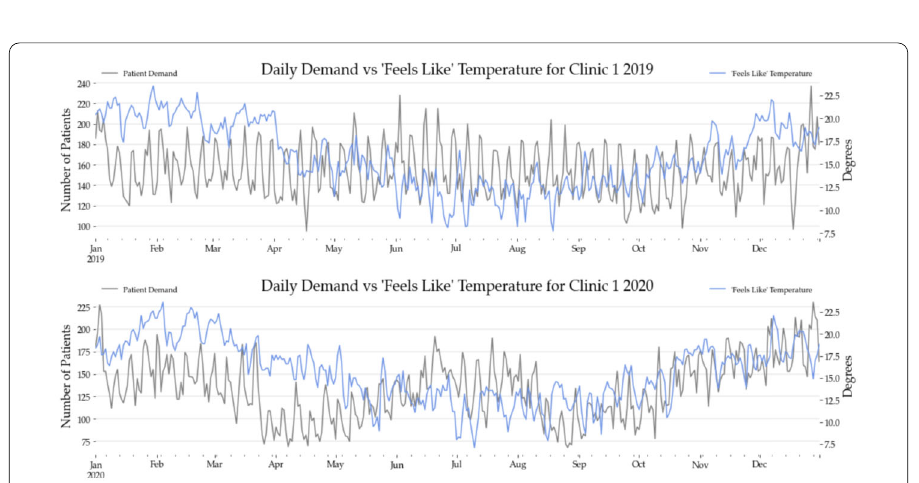
Figure 12 ‘Feels Like’ Temperature Proxy Feature for 2019 and